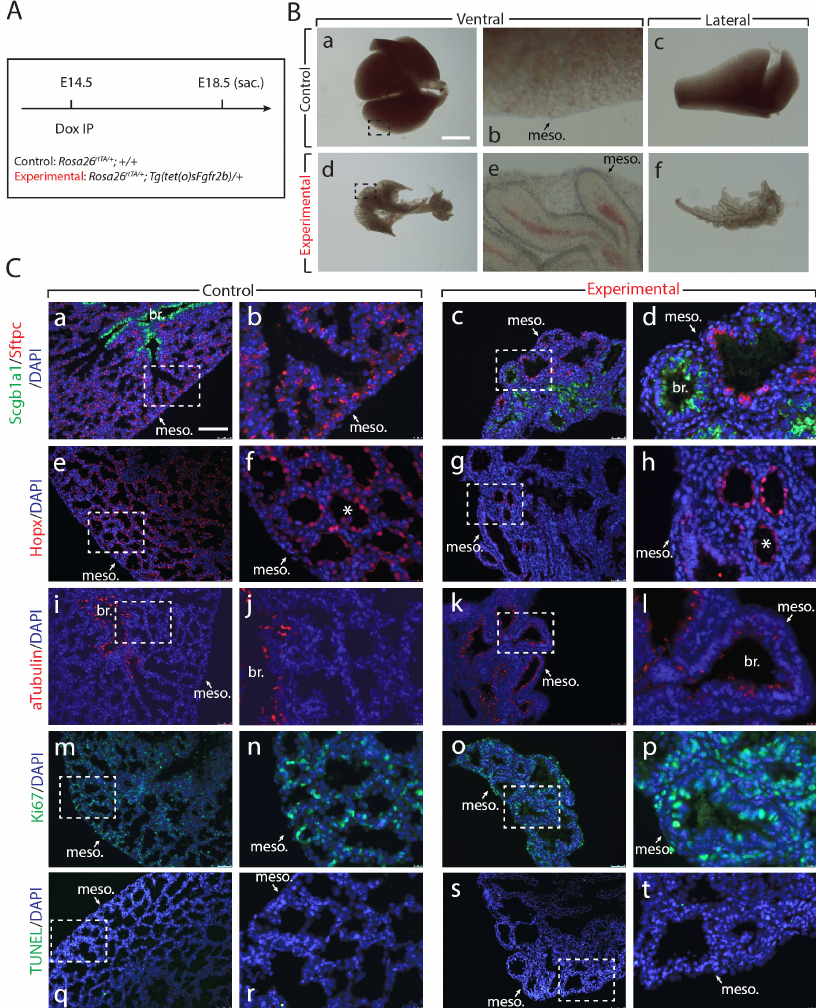
Figure 6. Experimental lungs are developmentally arrested after transient Fgfr2b signaling inhibition at E14.5. (A) Experimental design: pregnant females carrying experimental and littermate control embryos were injected with a single Dox-IP at E14.5, and embryos were harvested at E18.5. (B) Brightfield images of the ventral side of the whole lung in control (a, b) and experimental (d, e) samples, as well as the lateral perspective of the accessory lobe (c and f). Apart from the drastic difference in overall lung size between experimental and control lungs (d vs. a), notice the complete failure of the experimental epithelium to form the numerous branches and alveoli seen in the control, as well as the reduced mesenchyme and thickness of the lobes seen in the experimental lungs (f vs. c). (meso. = mesothelium). Scale bar: (a, d) 1.5 mm, (b, e) 95 µm, (c, f) 375 µm. (C) Immunofluorescent images (a-t) for control and experimental lungs. Antibody staining for AT1 (Hopx) and AT2 (Sftpc) cells suggests an overall reduction in the number of these cells in experimental compared to control lungs (compare c and g to a and e). Furthermore, in the case of Hopx staining in the experimental lungs (see g and h), there are cells with a similar expression pattern to the AT1 cells seen in controls, but also epithelial cells displaying a sparse, much reduced expression pattern (compare cells in the structure labeled by asterisks in h vs. f). Staining for the proximal epithelial markers Scgb1a1 and acetylated alpha-Tubulin reveals ectopic and distal expression in experimental compared to control lungs (compare d and l to b and j). Finally, staining for Ki67 (m–p) and TUNEL (q–t) to assess proliferation and apoptosis, respectively, shows that, in general, there is little to no impact on proliferative processes in either the epithelial or mesenchymal compartments. (meso. = mesothelium, br. = bronchus). Scale bar: (a, c, e, g, i, k, m, o, q, s) 125 µ m, (b, d, f, h, j, l, n, p, r, t) 25 µ